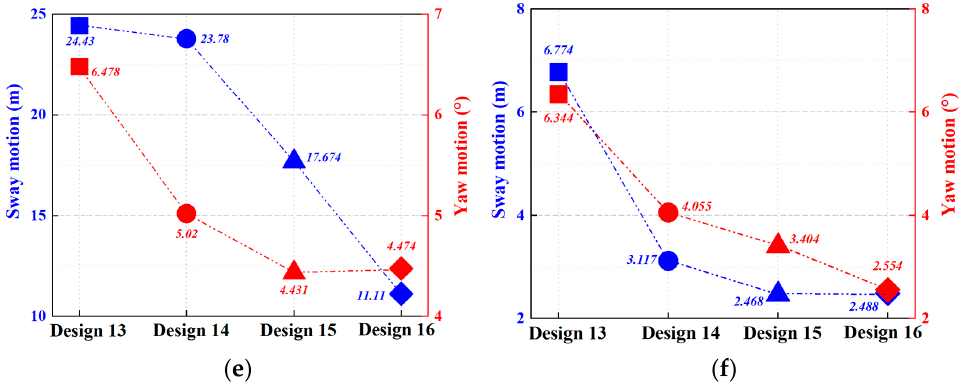
Figure 11. Sway and yaw motion of the platform under different environmental loads. ( a ) Sway and yaw motion in four-thrusters (Pattern 1) design under wave load; ( b ) Sway and yaw motion in four-thrusters (Pattern 1) design under level ice; ( c ) Sway and yaw motion in four-thrusters (Pattern 1) design under broken ice floes; ( d ) Sway and yaw motion in eight-thrusters design under wave load; ( e ) Sway and yaw motion in eight-thrusters design under level ice; ( f ) Sway and yaw motion in eight-thrusters design under broken ice floes.